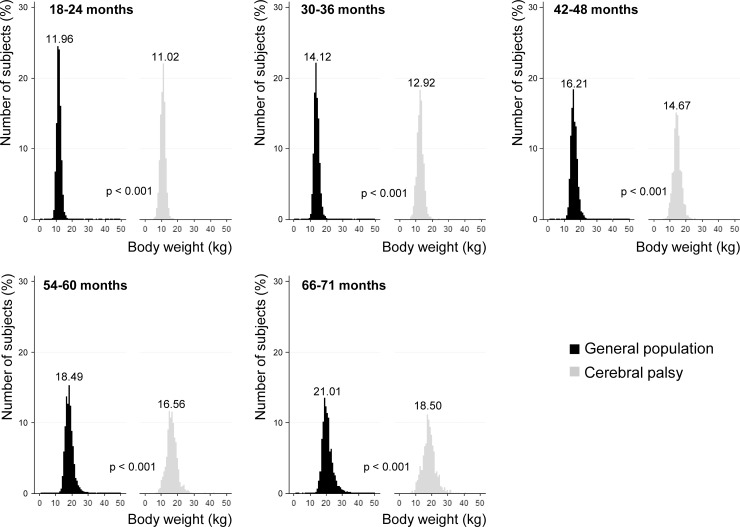
Comparison of follow-up body weight.Comparisons were made for follow-up body weight between subjects in the general population and subjects with cerebral palsy at each National Health Screening Program for Infants and Children. The number on each graph is the mean value of follow-up body weight.